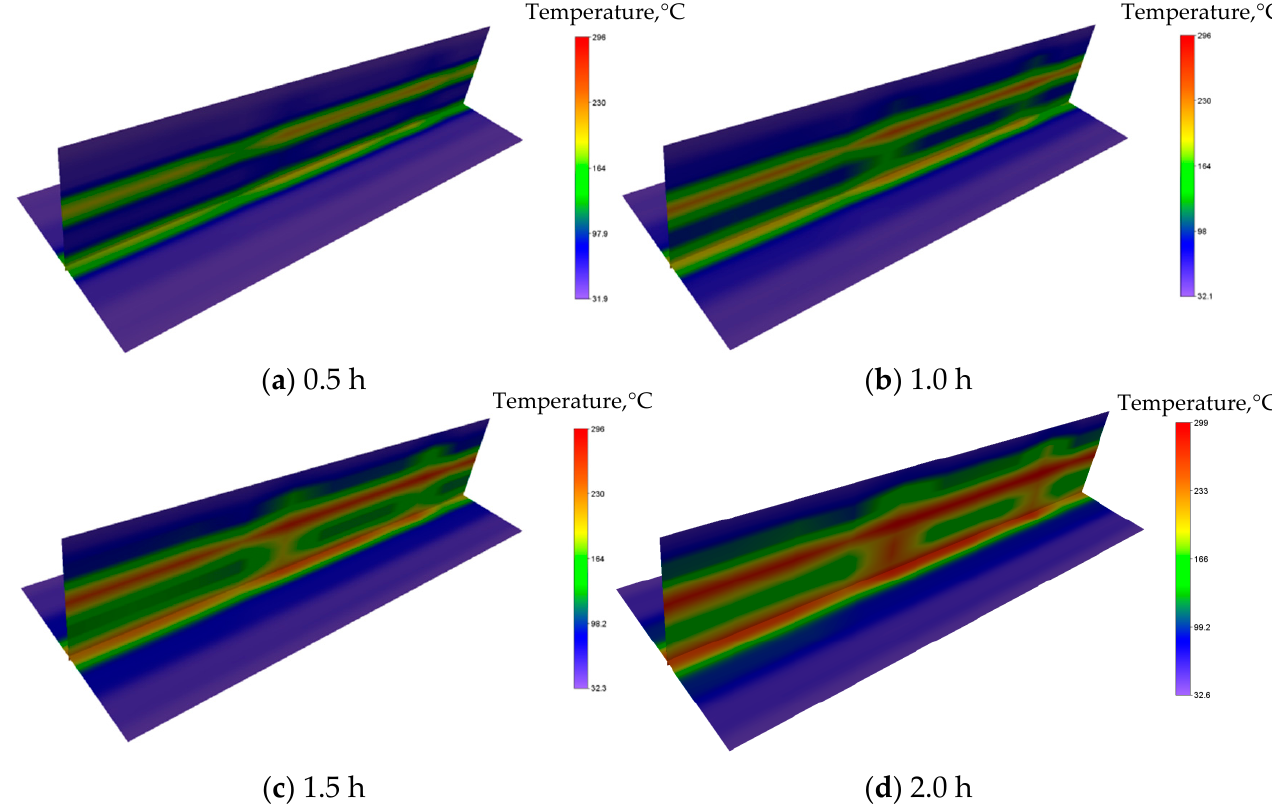
Figure 3. Temperature fields of SAGD start-up by electrical heating. h means hours.